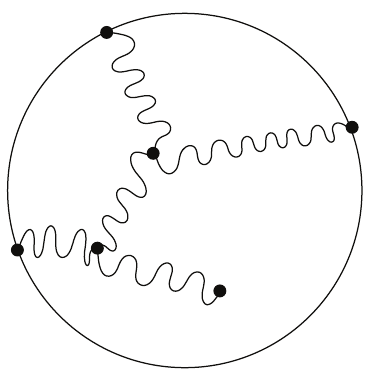
Figure 16: Witten diagram 3, created by Daniel